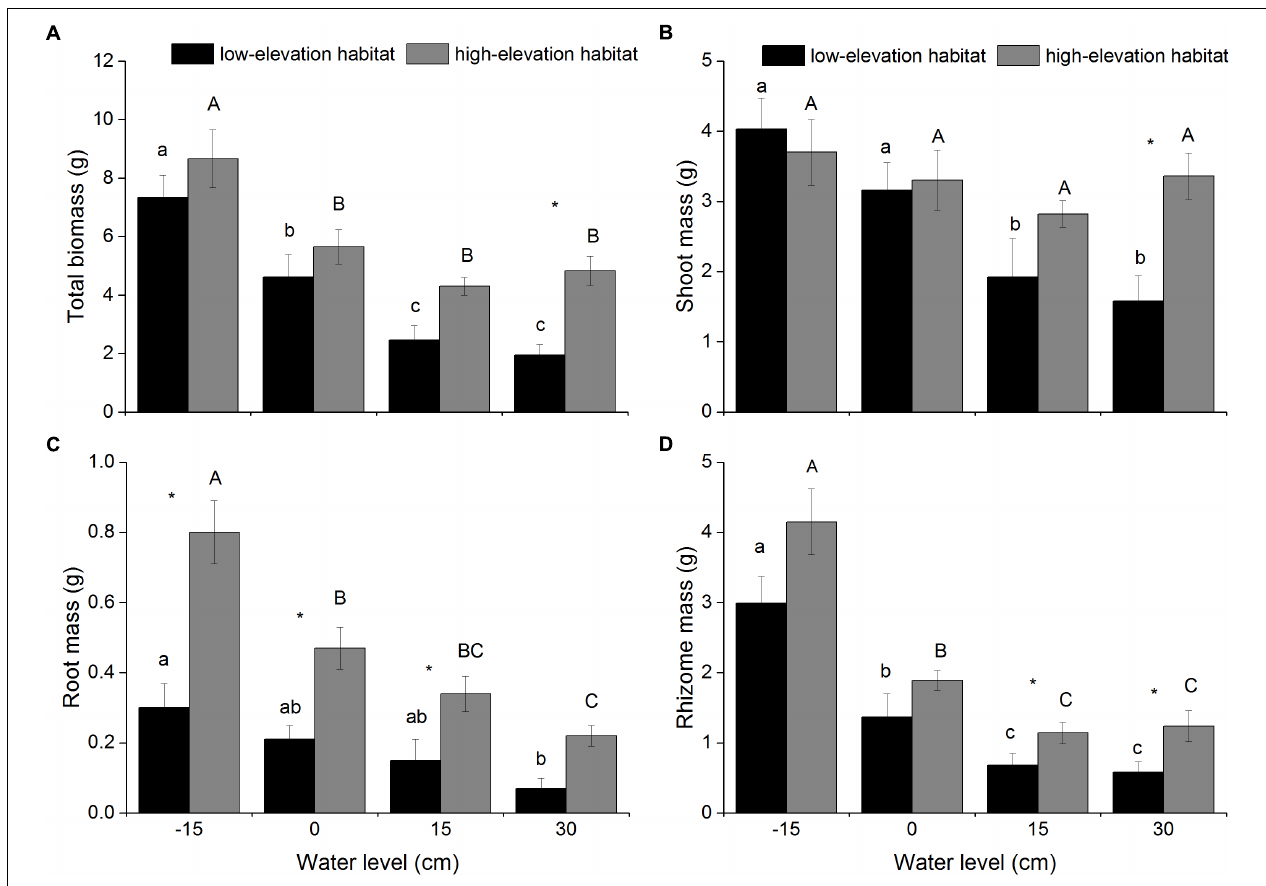
FIGURE 1 | Total biomass (A) , shoot mass (B) , root mass (C) , and rhizome mass (D) of P. hydropiper plants originating from two habitats grown under four water levels. Different lower-case or capital letters indicate that means differ significantly between the water-level treatments for plants originating from low-elevation and high-elevation habitats, respectively. Symbols ( ∗ ) show which means differed between habitat types at each of the four water